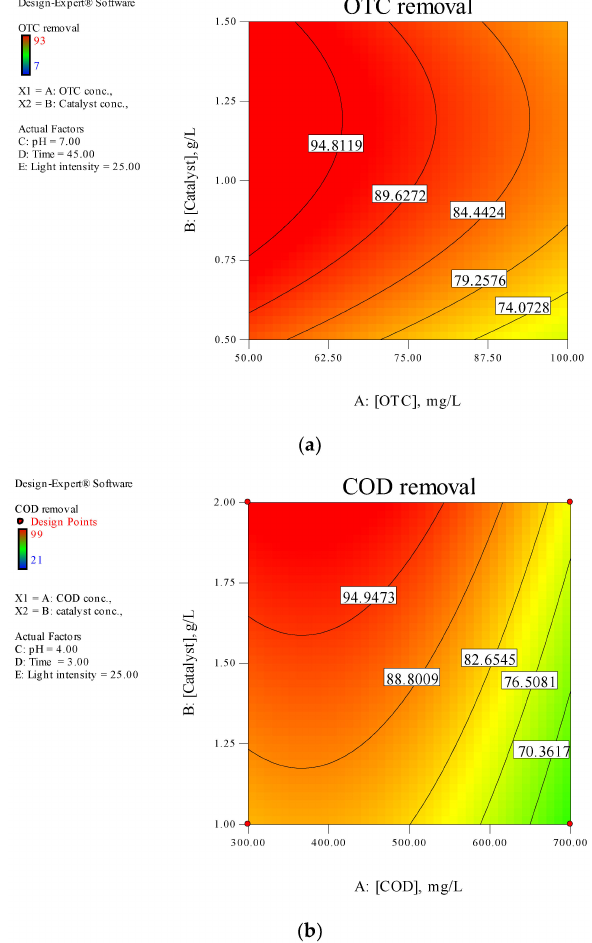
Figure 7. Contour plot of ( a ) OTC and ( b ) COD removal efficiency as a function of pollutant concentration and catalyst